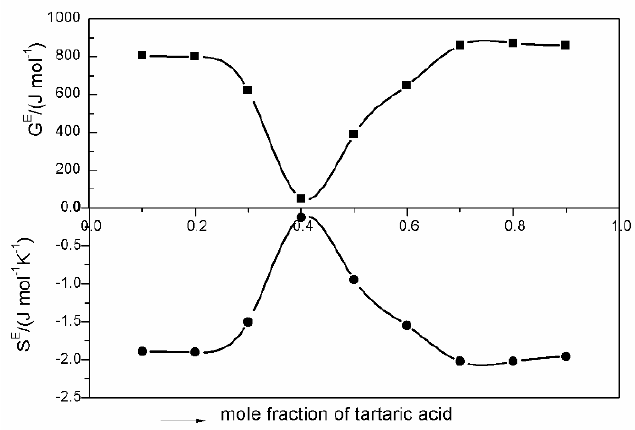
Figure 3. Excess functions G E and S E for binary system citric acid - tartaric acid.